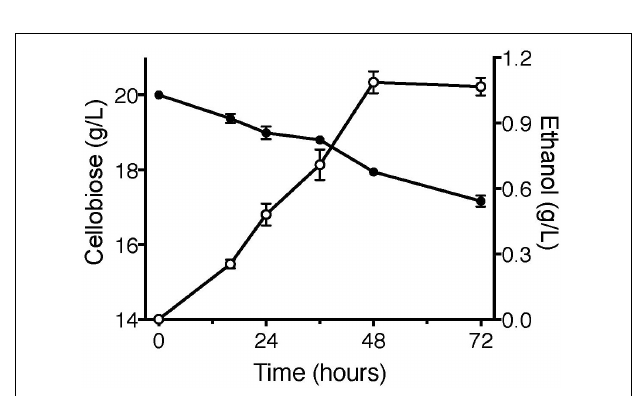
FIGURE 5 | The anaerobic fermentation of YP β G-CtA on cellobiose.